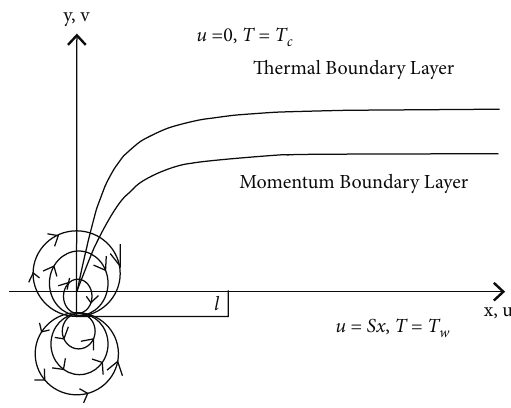
Figure 1: Geometry of the MgZn6Zr-C8H18 nanofluid Table 1: Thermophysical properties of engine oil C